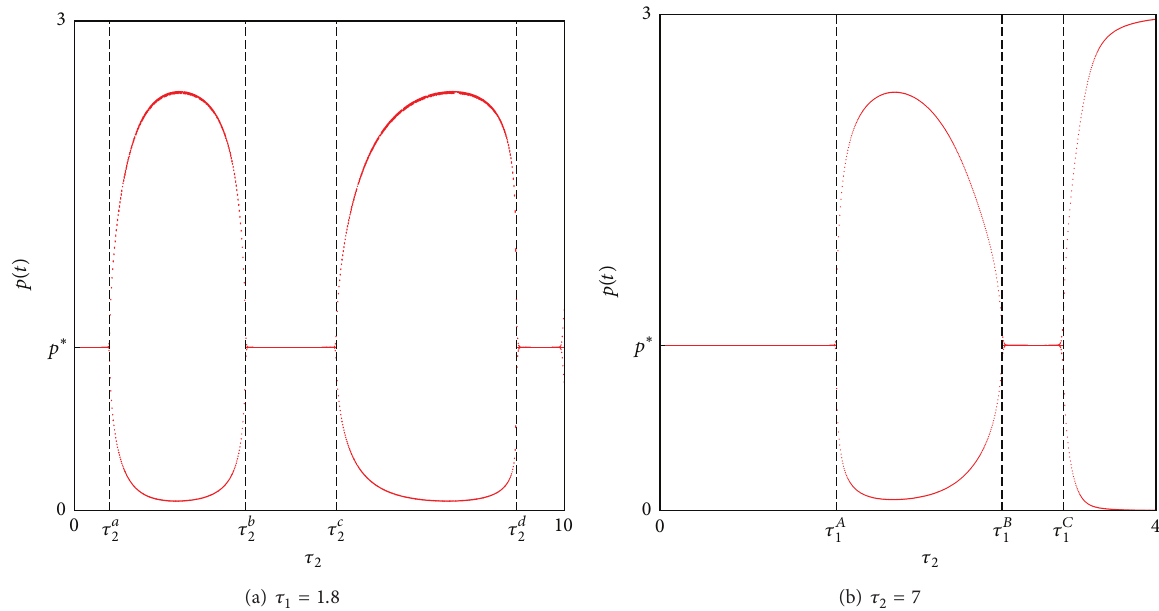
Figure 3: Bifurcation diagrams showing stability losses and gains.